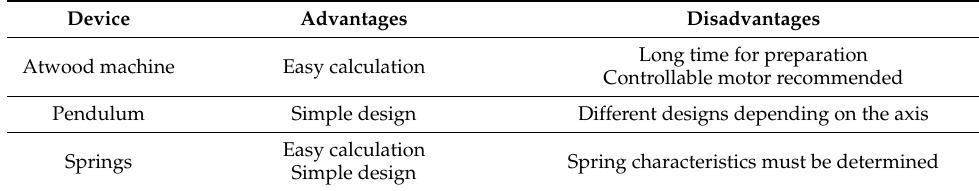
Table 1. Comparison of the different approaches to determine the MOI experimentally.